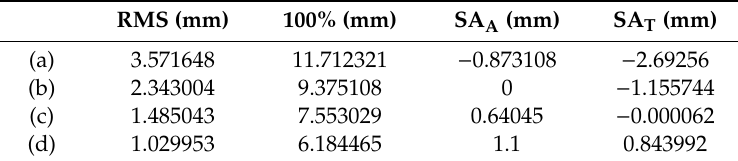
Table 3. Spot size and the spherical aberration change due to the radiation correction of the synthesized optical